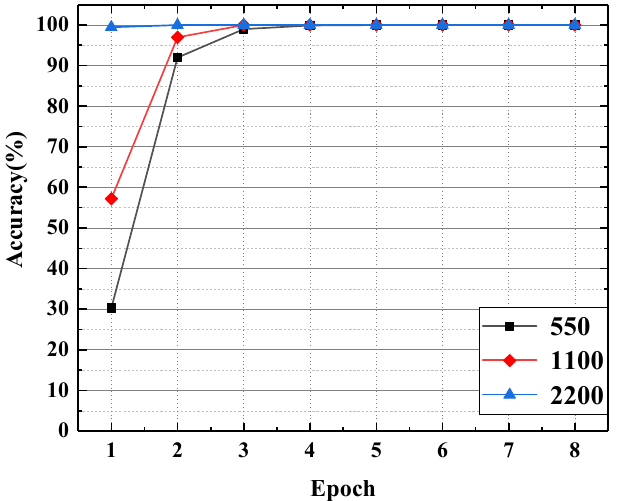
Figure 6. The MFI accuracies at different epochs for different sample numbers. The sample numbers of each format are 550, 1100, and 2200.